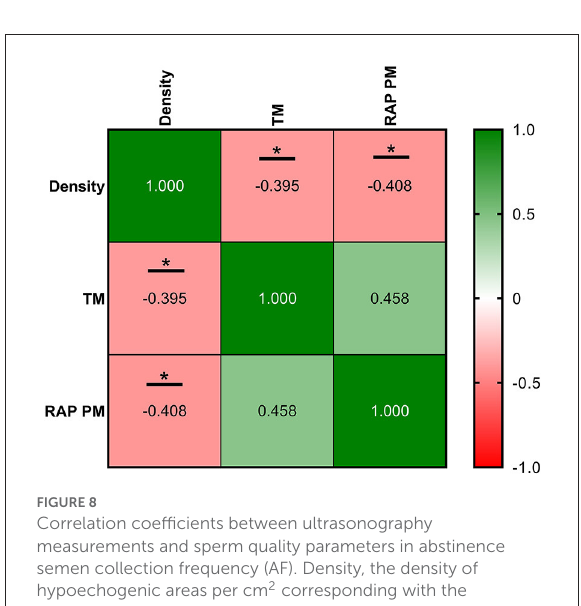
FIGURE8 Correlation coefficients between ultrasonography measurements and sperm quality parameters in abstinence semen collection frequency (AF). Density, the density of hypoechogenic areas per cm 2 corresponding with the seminiferous tubules; TM, total motility (%); RAP PM, rapid progressive motility (%). The same 25 males were analyzed in each parameter. The R squared value between two parameters is represented in each cell and graph. In the correlation matrix, green color indicates positive correlations, and red color indicates negative relationships. The color intensity represents the strength of the correlation between two parameters. Asterisks show significant correlations ( P ≤ 0.05) between ultrasonography measurements and sperm quality